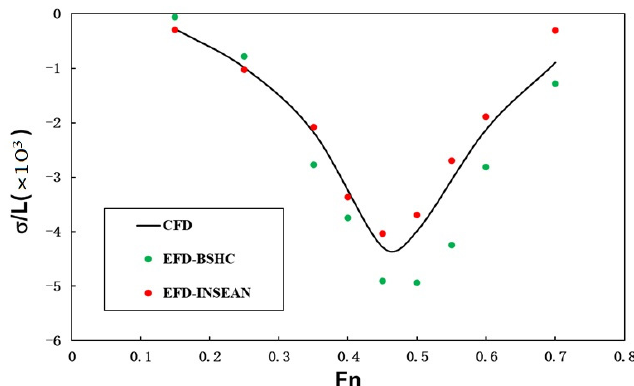
Figure 11. Comparison of the sinkage between CFD and EFD